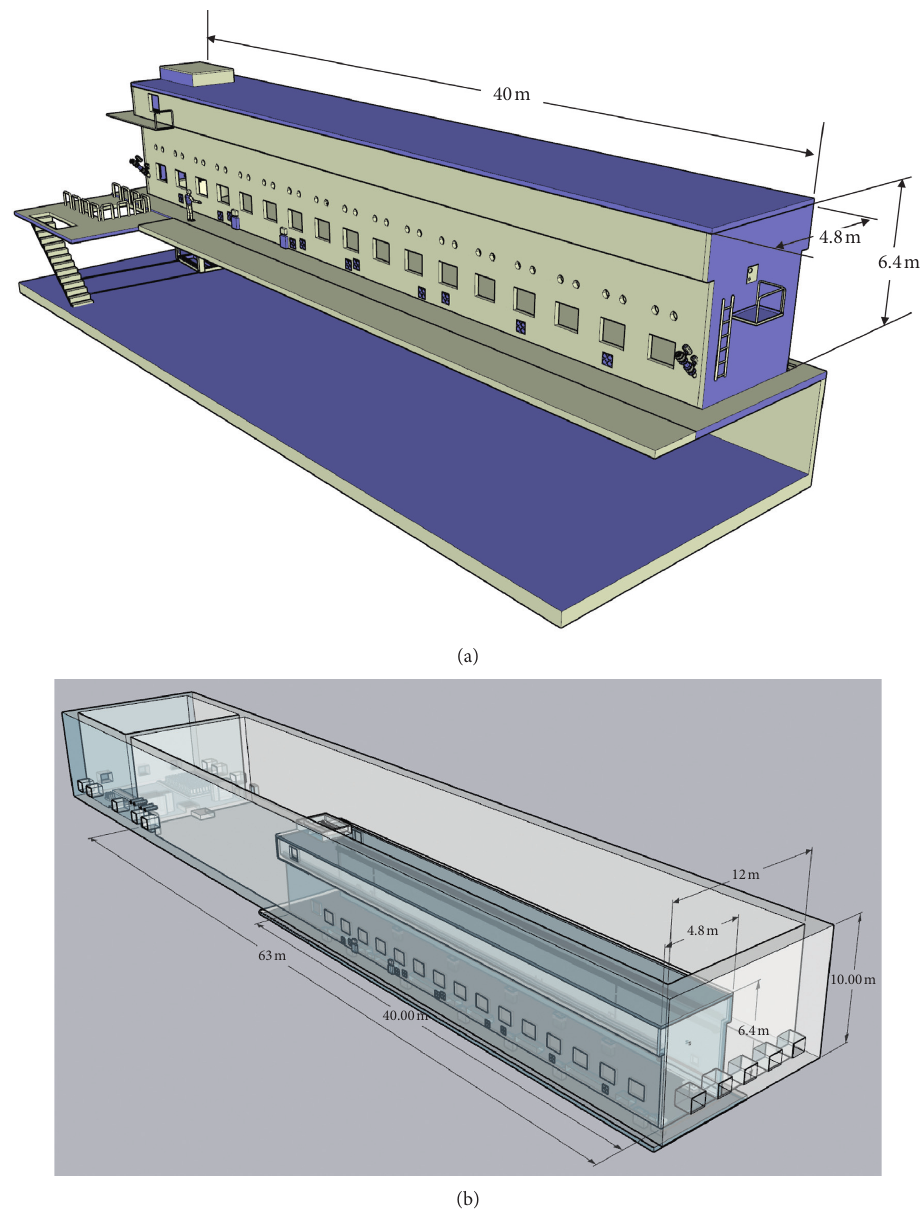
Figure 8: Dimensional comparison of PRIDE (pilot-scale facility) and the target facility (demonstration facility). (a) Dimensions of argon cell in the PRIDE facility. (b) Comparison of dimensions of PRIDE and the target